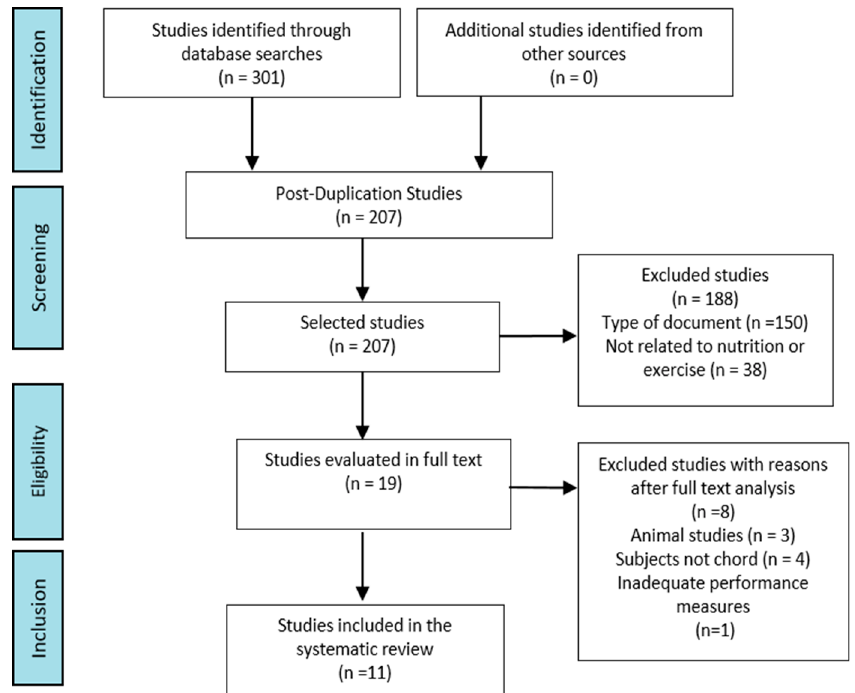
Figure 1. Selection of Studies.